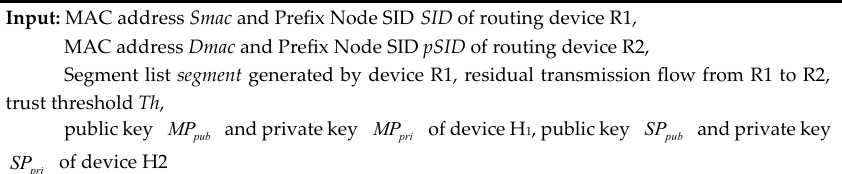
Algorithm1 data exchange security algorithm in the mode for the network element to generate Segment